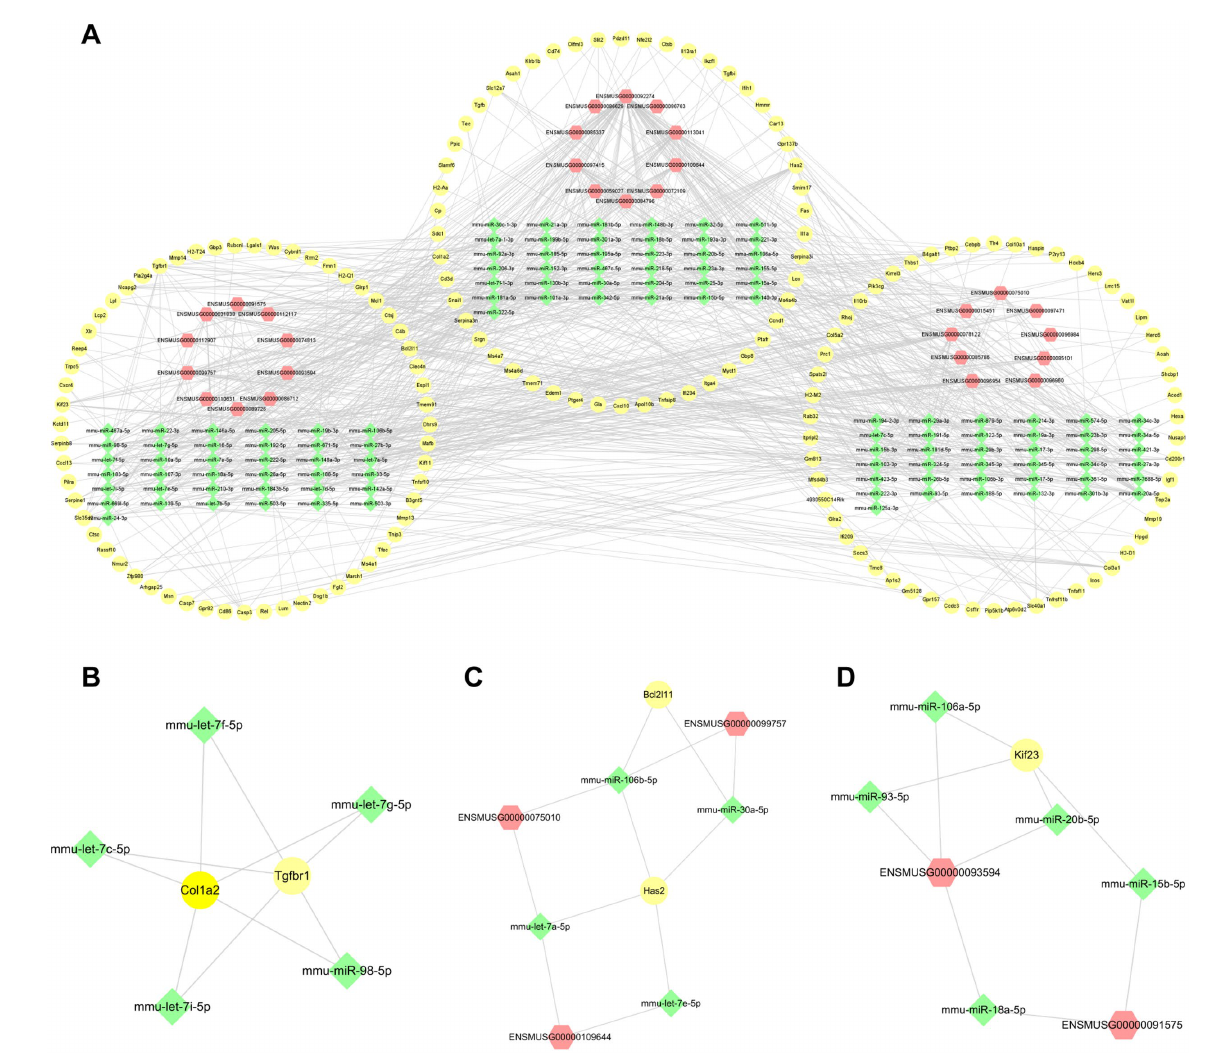
FIGURE 8 The lncRNA-miRNA-mRNA interactions post-ICH. (A) The ce-RNA network post-ICH. The hub clusters of the ce-RNA network: are Cluster1 (B) , Cluster2 (C) , and Cluster3 (D) . The yellow circles represent mRNAs, green rhombuses represent miRNAs, and red hexagons represent